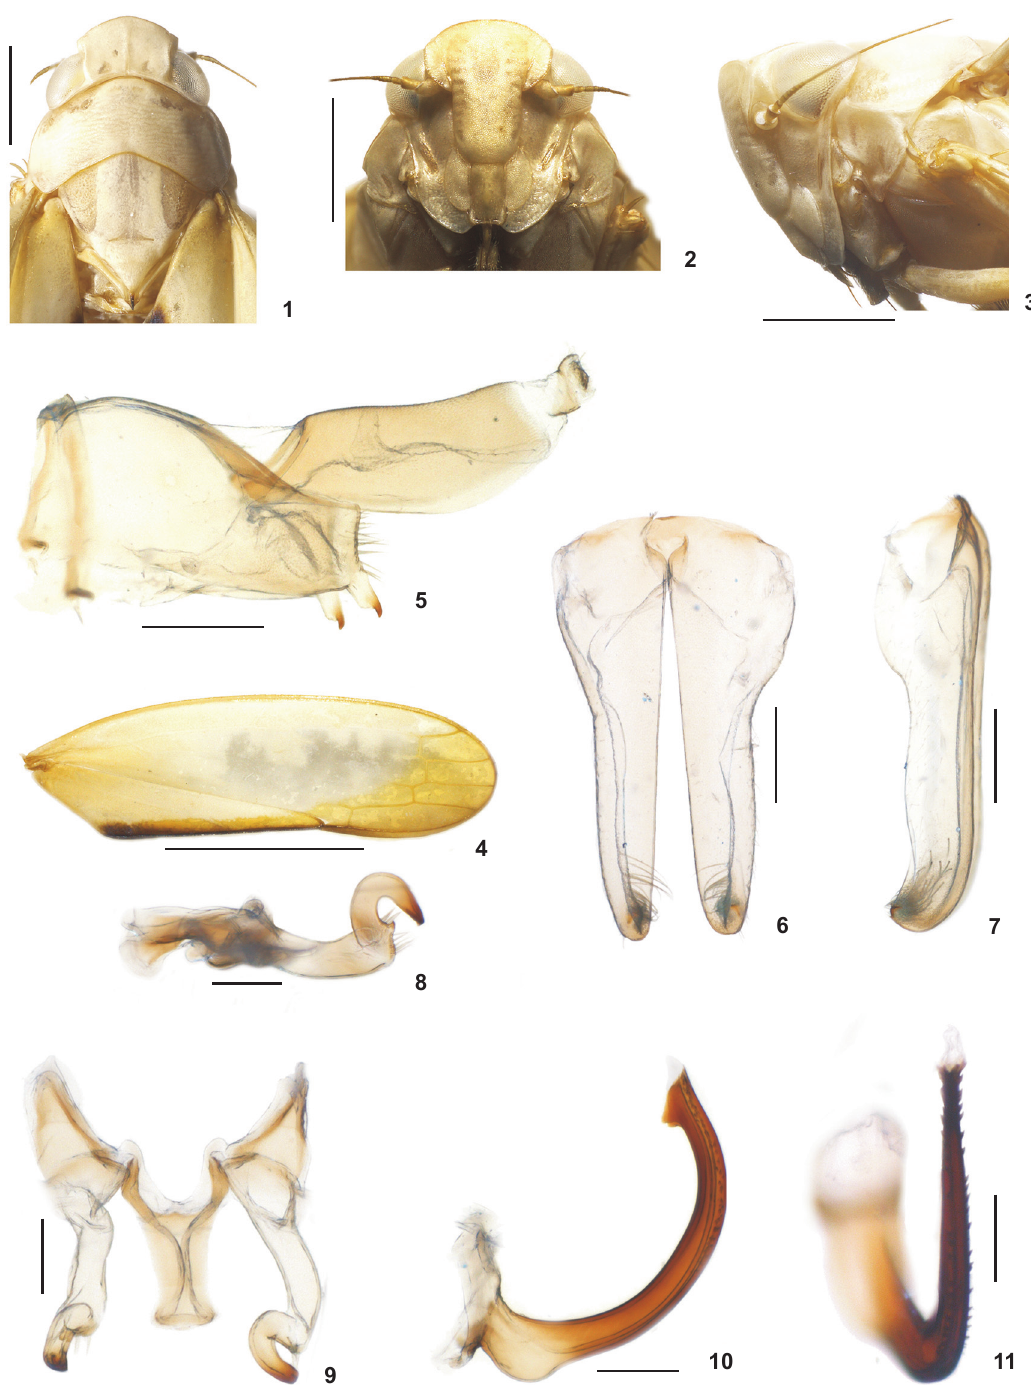
Figures 1-11. Placoscopana nigrilinea sp. nov. , male holotype: (1) head, pronotum, mesonotum, and base of wings, dorsal view; (2) head, frontal view; (3) head, pronotum, mesonotum, and base of wings, lateral view; (4) forewing; (5) pygofer and anal tube, lateral view; (6) valve and subgenital plates, ventral view; (7) valve and subgenital plates, lateral view; (8) style, lateral view; (9) connective and styles, dorsal view; (10) aedeagus, lateral view; (11) aedeagus, posterior view. Scale bars: 1-3 = 1.0 mm, 4 = 2.0 mm, 5-7 = 0.5 mm, 8-11 = 0.2